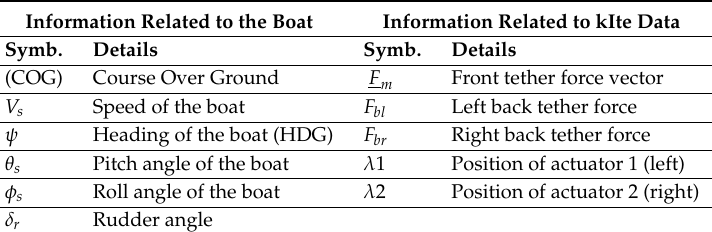
Table 1. Major variables recorded during